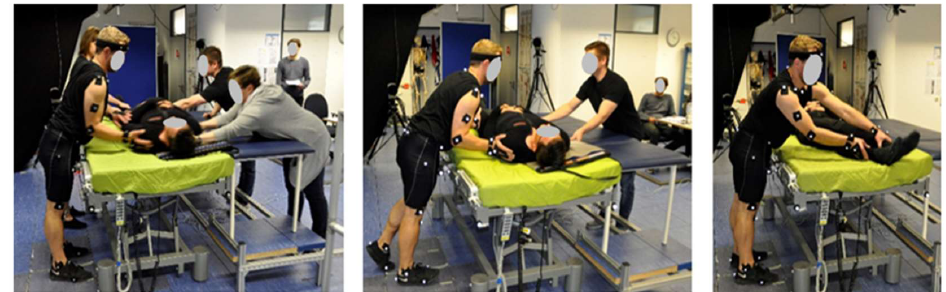
Figure 9. Manual handling tasks reproduced in the motion lab (left: pushing in a team; middle: pushing with less help and right: manually lifting the patient´s